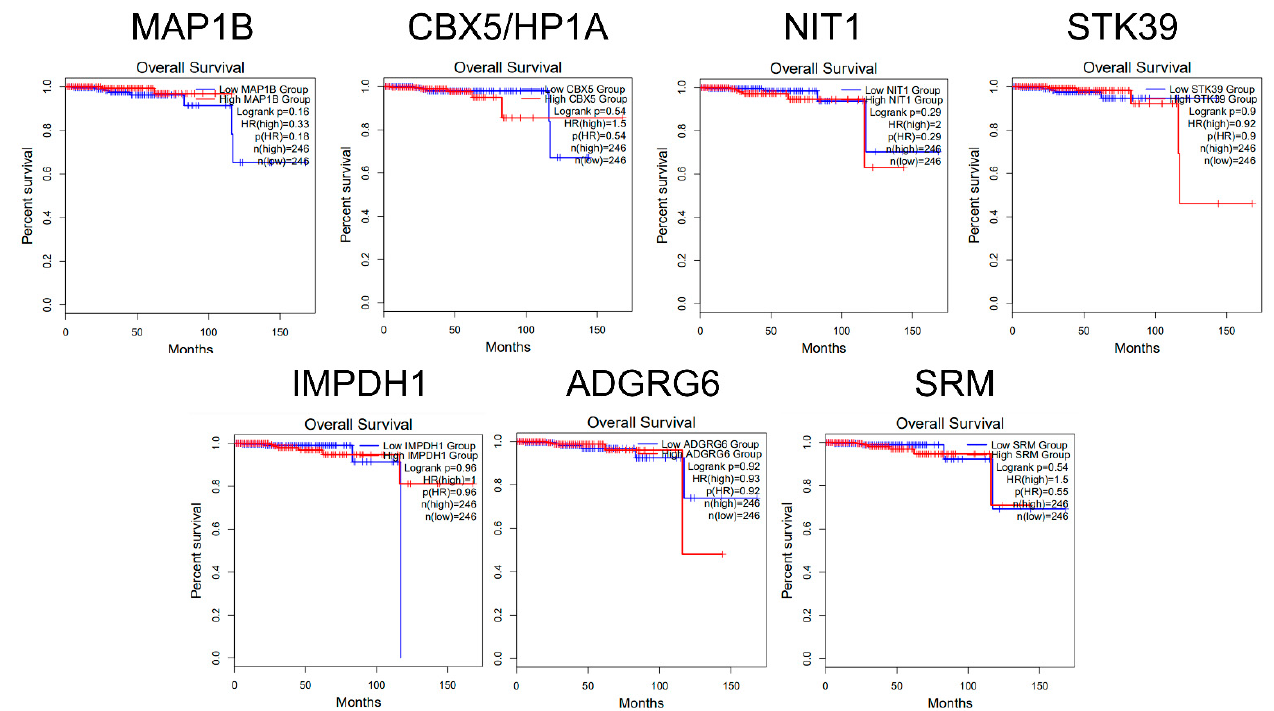
Figure 6. Kaplan–Meier plots for mRNA expression derived from the online GEPIA2 tool for sets of high (red) and low (blue) expression level cohorts. ‘N’ represents the size of the patient cohorts involved in the study with high and low expression of mir-423-5p targets.